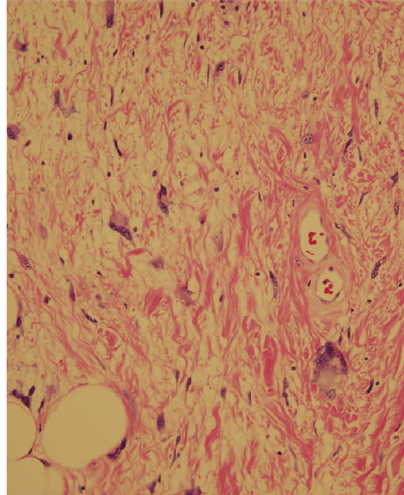
Figure 3: Light microscopy demonstrates atypical adipocytes with enlarged nuclei, hyperchromasia, and intranuclear